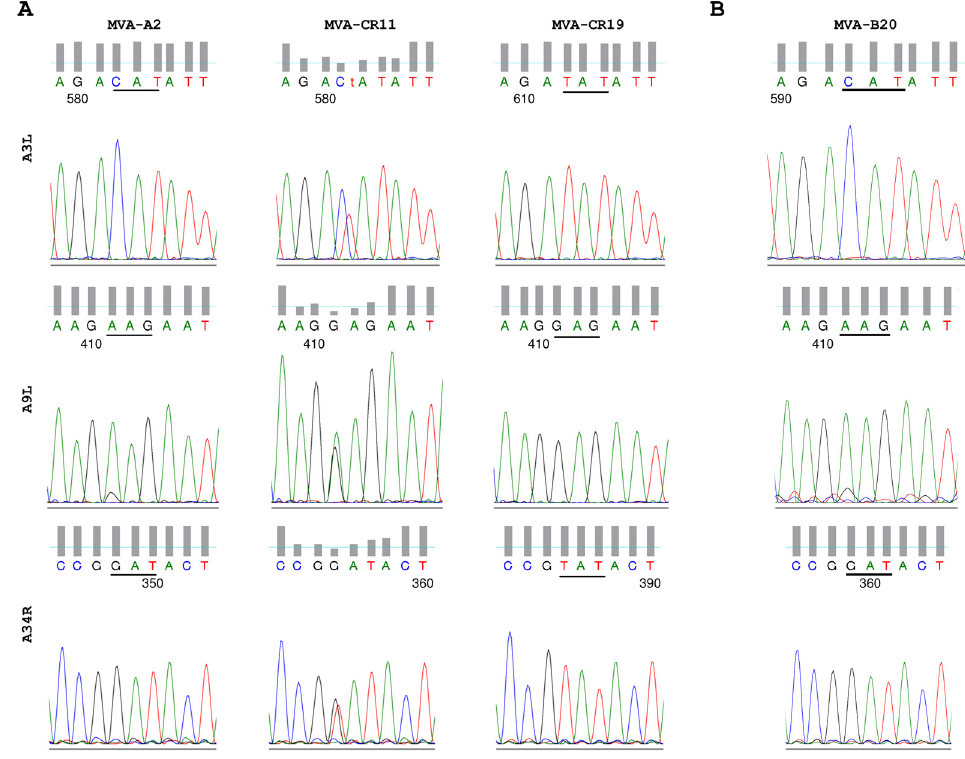
Figure 2. MVA-CR19 is a pure isolate of MVA-CR. ( A ) Conventional sequencing chromatograms covering the affected region of A3L, A9L, and A34R in the seed virus MVA-A2, the intermediate isolate MVA-CR11, and plaque-purified isolate MVA-CR19. ( B ) The A3L, A9L, and A34R genes remain free of mutations after repeated passages in adherent CR.pIX and mammalian R05T cells. Shown here are the sequences for isolate MVA-B20 that was obtained after 20 passages on adherent CR cells (see also Figure